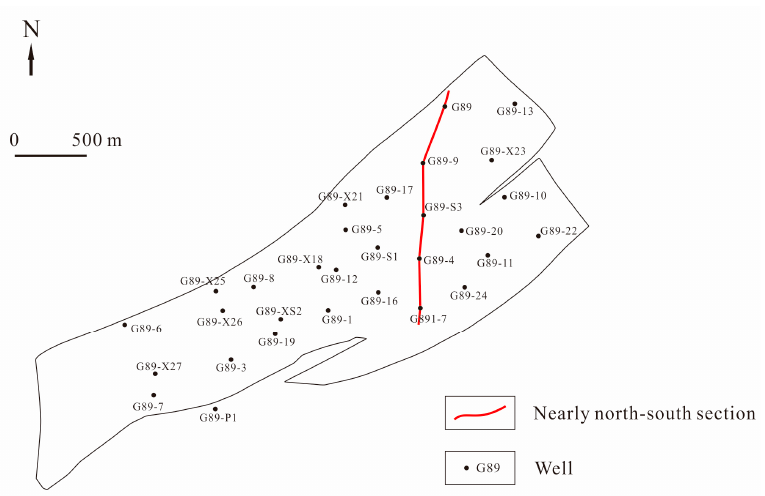
Figure 16. Well distribution and the nearly north-south section position in the study area.